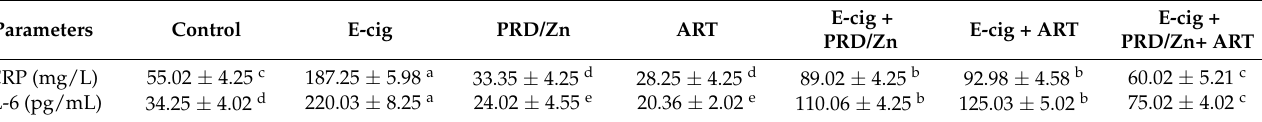
Table 2. EffectsofE-cigsoninflammatorymarkersandbeneficialeffectsofPRD/ZnandARTinmale